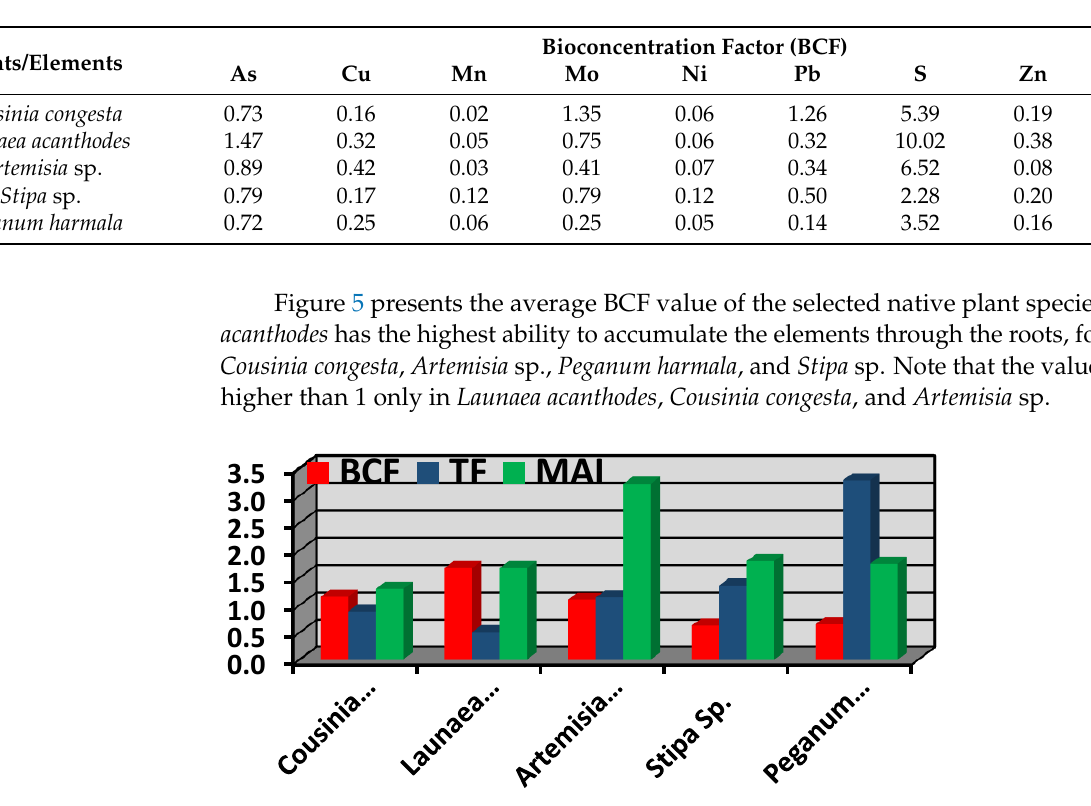
Figure 4. The zoning map of plant uptake values based on the MAI in the Khatunabad plain. Table 5. The bioavailability index of the sampled native plants for the most polluted station of the different elements.